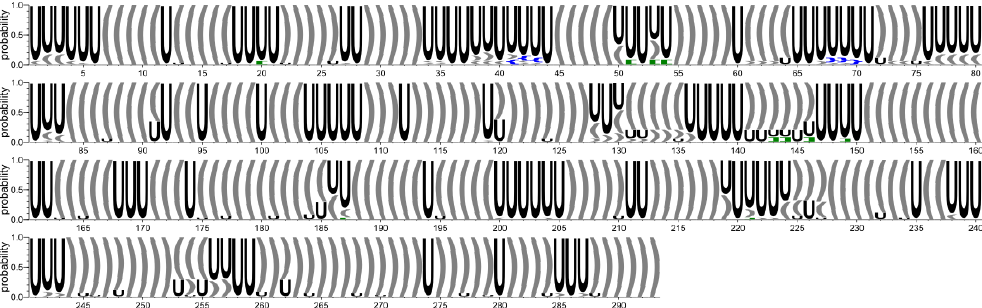
Figure 2. Secondary structure conservation diagram for the 5 (cid:48) -UTR region. ‘U’ corresponds to unpaired residue. According to the DBL representation of the secondary structure topology [50], square brackets [ ] (green) represent pseudoknots of the first order, while curly brackets { } (blue) represent second order pseudoknots.